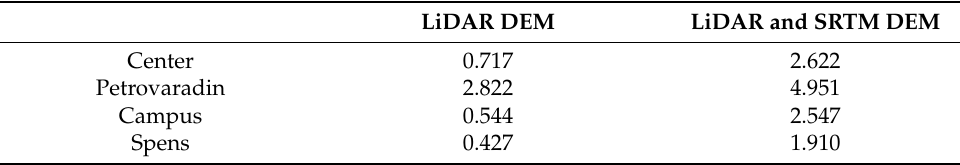
Table 2. Standard deviations of LiDAR DEM differences and LiDAR and SRTM DEM spatial resolu- tions 30 ×